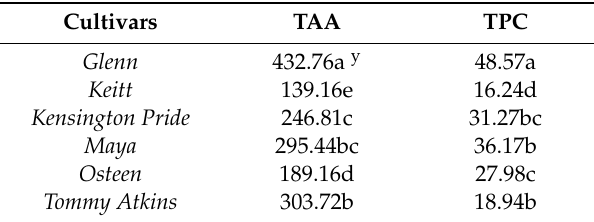
Table 7. Bioactive compounds of the six mango cultivars in trial. Total antioxidant activity (TAA) and total polyphenolic content (TPC).